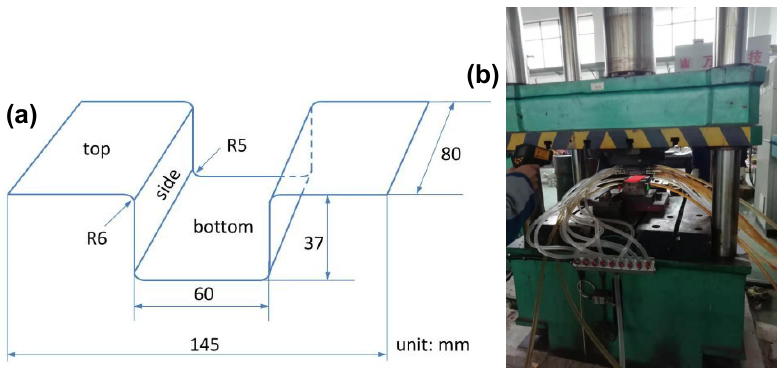
Figure 2. Schematic diagram of hot stamping of U-shaped part(a) and the shaper for U-shaped part(b). Figure 1. Schematic diagram of continuous annealing .